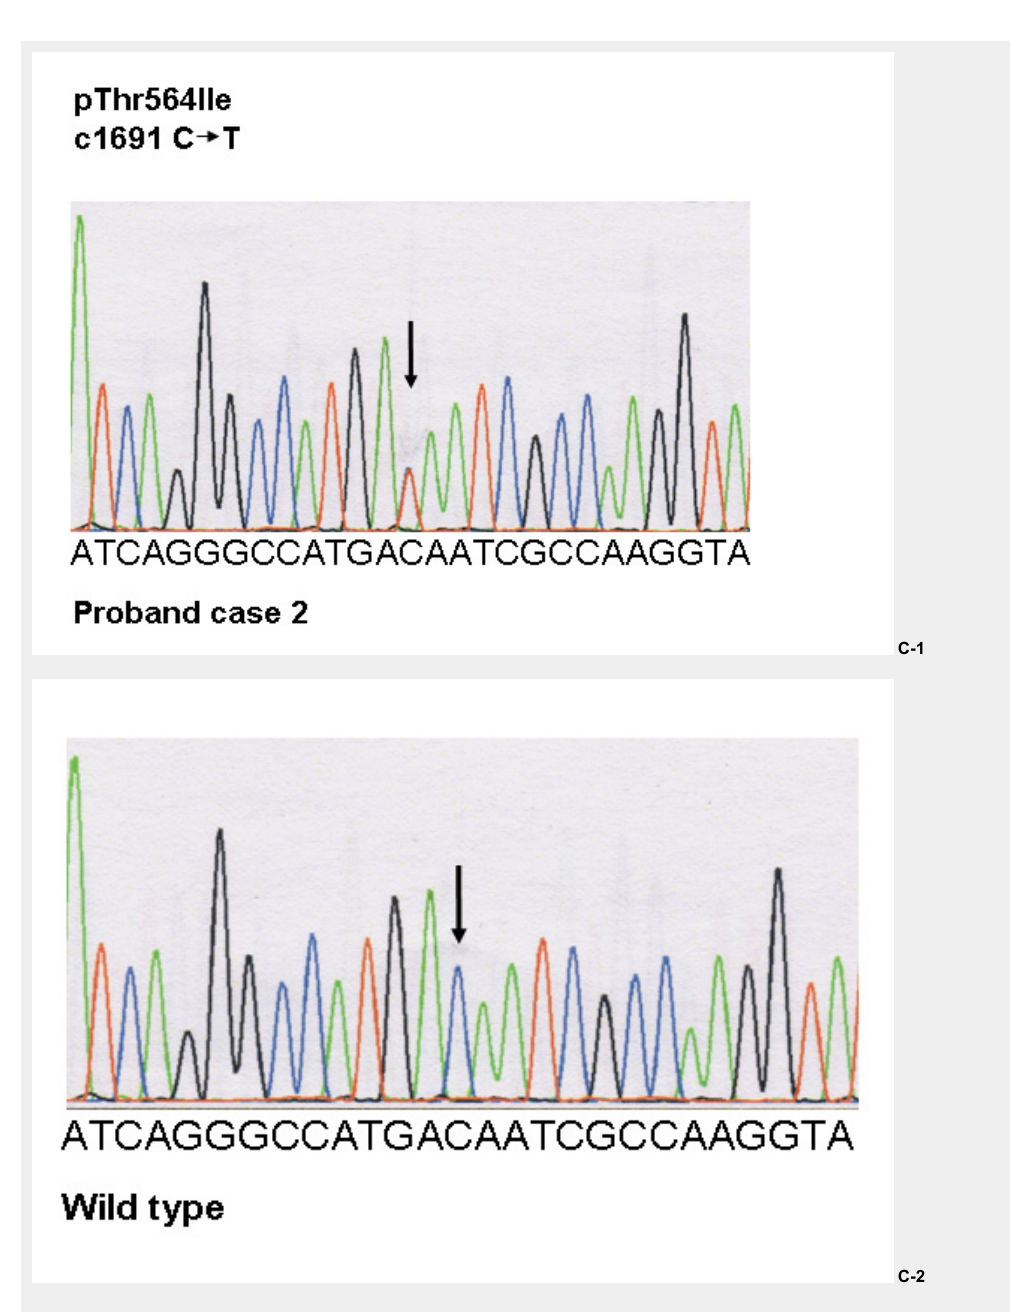
Figure 2 Transthoracic echocardiography, and genetic screening of case 2. A Parasternal short axis view. Right atrium and right ventricular infundibulum are indicated. The right ventricular infundibulum diameter is measured at the level of the aortic valve. RA = right atrium; RV = right ventricular infundibulum. B Apical four chamber view. Right ventricular trabeculations are visible at the free wall level. RV = right ventricle; Trab = trabeculations; LV = left ventricle. C Electrophoregrams of the desmoplakin mutation and of wild type: a heterozygous variant in DSP , c.1691 C>T, was identified, resulting in the missense mutation p.Thr564Ile at a heterozygous